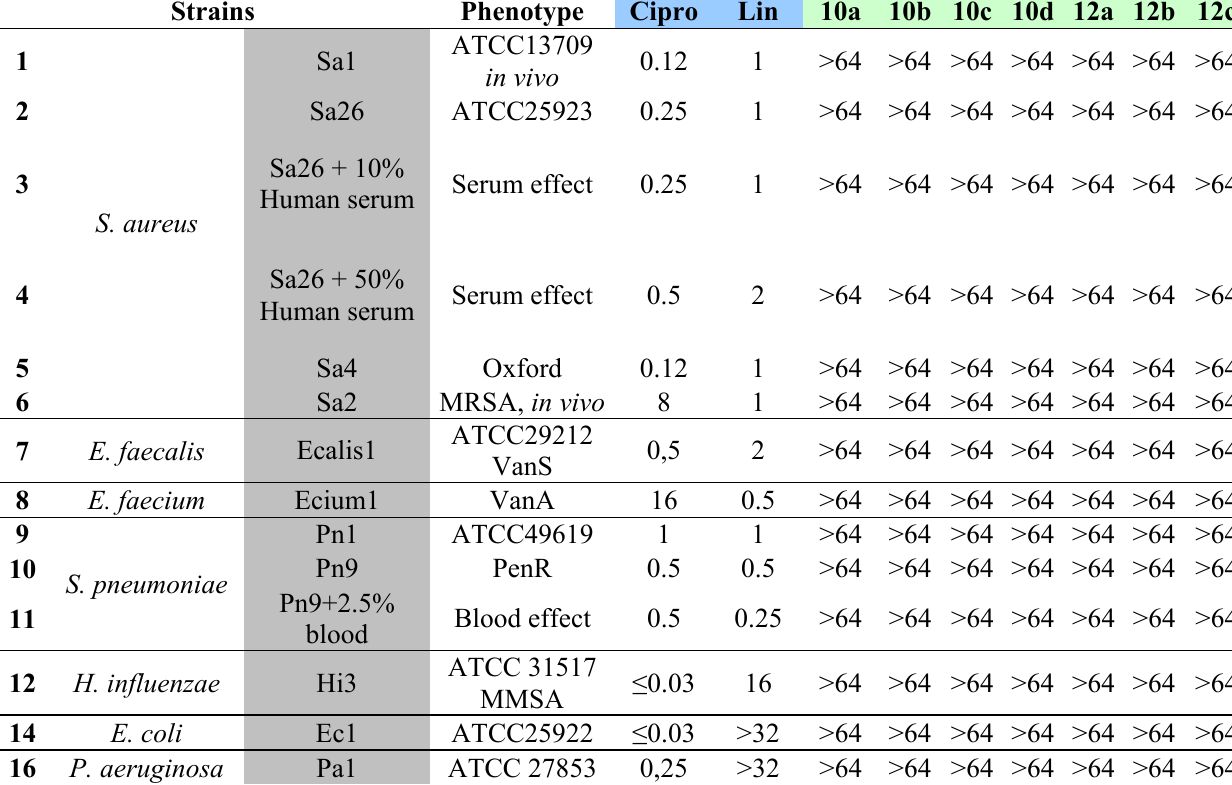
Table 2. Minimum inhibitory concentration (MIC) in μ g/mL of